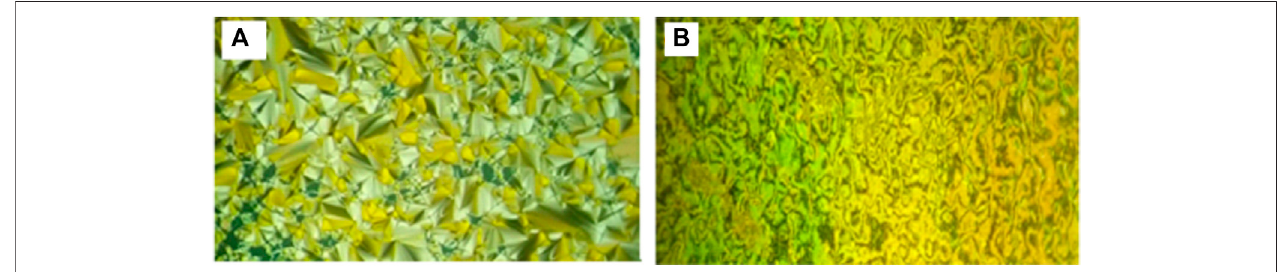
FIGURE 8 | Textures upon heating as observed under POM for SMHBC I/A6: (A) SmA phase 98.0 ° C; (B) Nematic phase at 128.0 ° C.